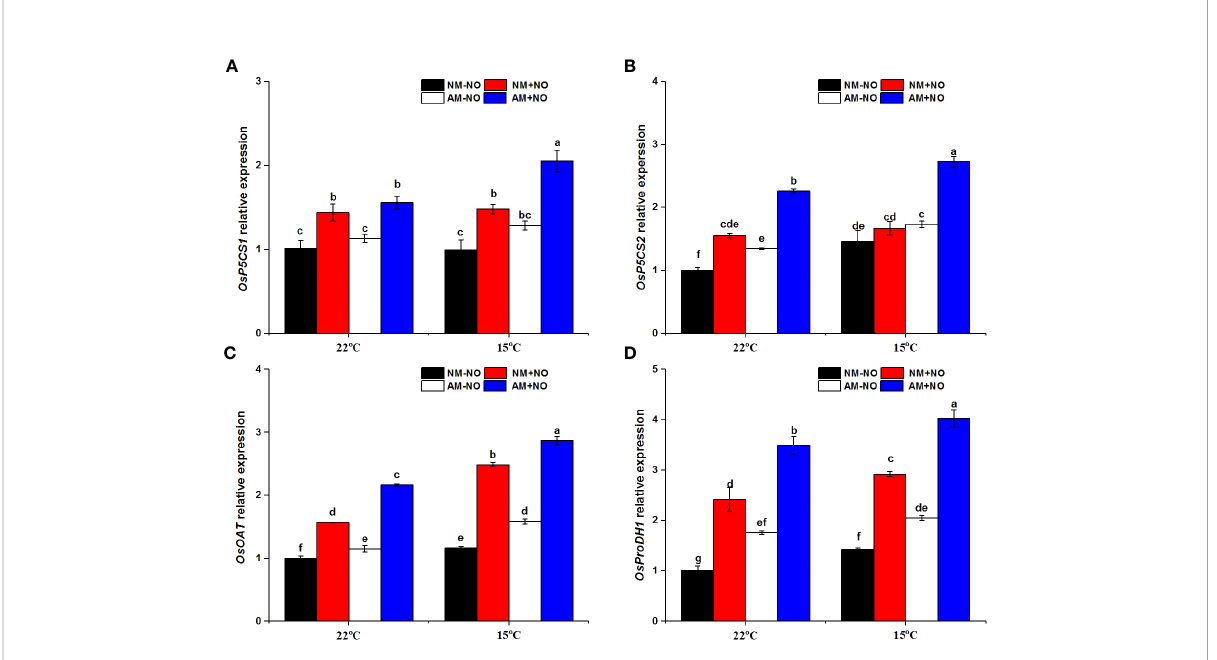
FIGURE 3 Relative expression levels of OsP5CS21 (A) , OsP5CS2 (B) , OsOAT (C) and OsProDH 1 (D) in non-mycorrhizal and mycorrhizal rice treated with different temperatures (25°C and 15°C) and exogenous NO. Abbreviations are de fi ned in Figure 1. Values are the means ± standard errors of three biological replicates. Different letters in the column represent signi fi cant differences (P<0.05) based on Duncan ’ s